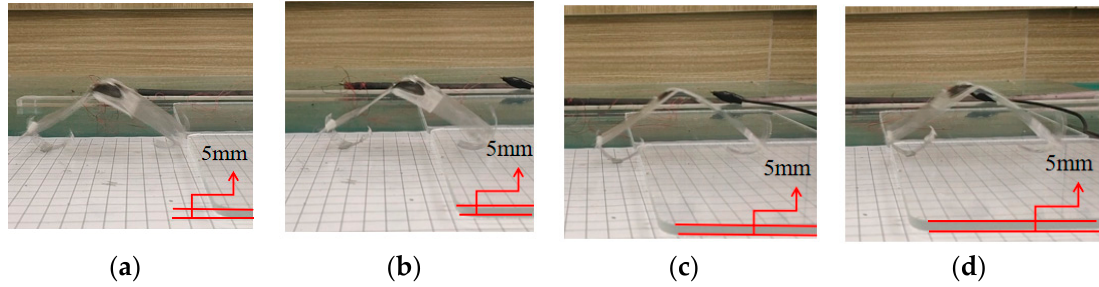
Figure 9. Jumping experiment. ( a ) Front foot touches obstacle; ( b ) Front foot jumps over obstacle; ( c ) Rear foot touches obstacle; ( d ) Rear foot jumps over obstacle.